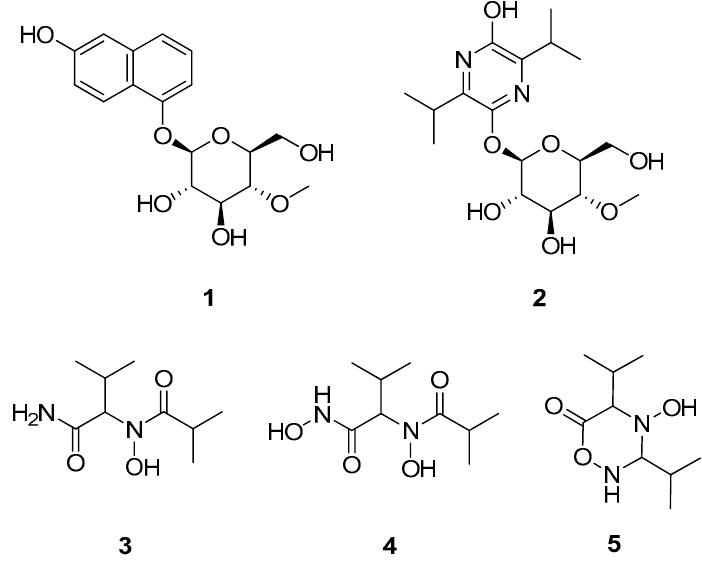
Figure 1. Structures of Compounds 1 – 5 .